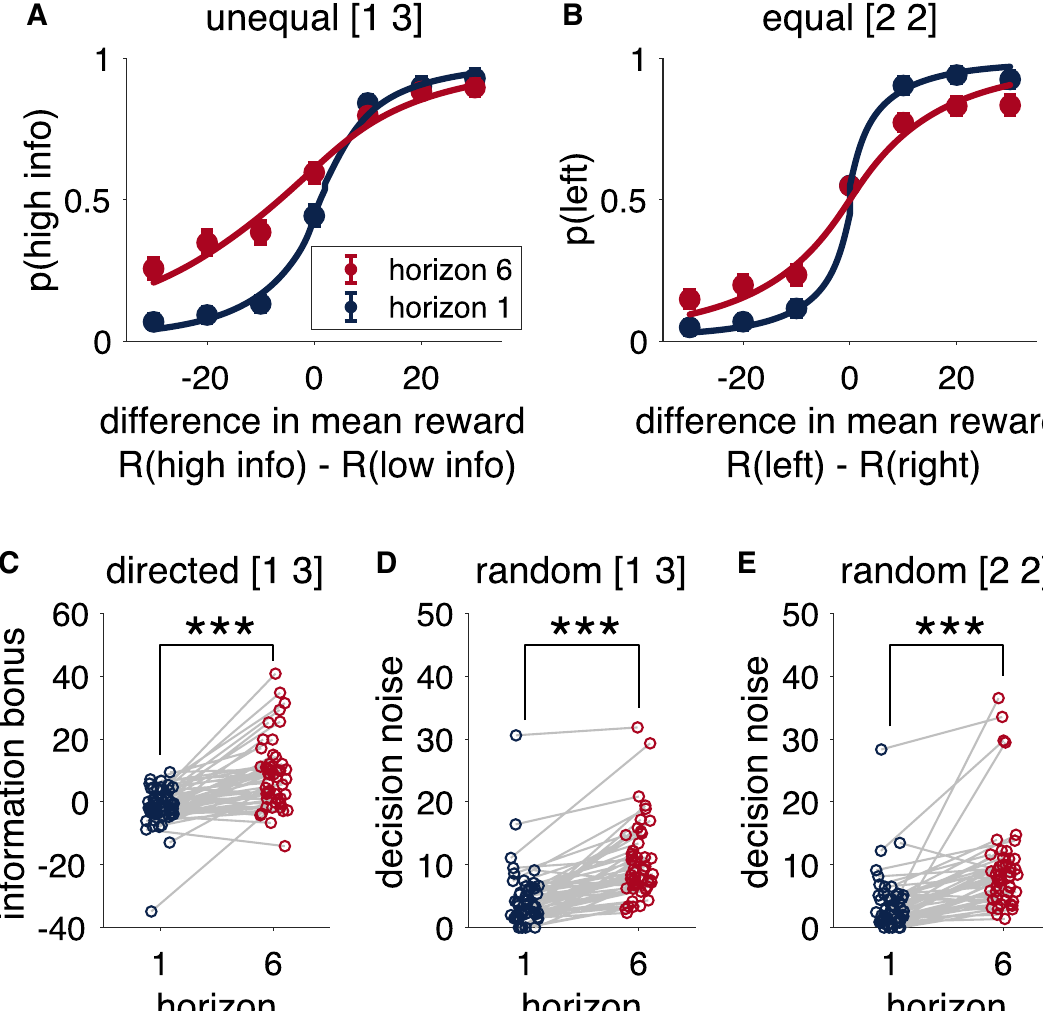
Figure 3. Choice behavior in the Horizon Task. ( A , B ) Choice curves showing the choice probability as a function of the difference in observed mean reward. ( A ) The probability of choosing the more informative option (i.e. the option played once during the instructed trials) as a function of the difference in observed reward between the more informative, R ( high info ) and less informative R ( low info ) bandits. ( B ) The probability of choosing the left bandit as a function of the difference in observed mean reward between the left and right options. ( C , D , E ) Fit parameter values, in units of points, from the logistic model showing the information bonus ( C ), as well as the standard deviation of the decision in the unequal ( D ) and equal ( E ) conditions. *** denotes a significant difference at p < 0.001